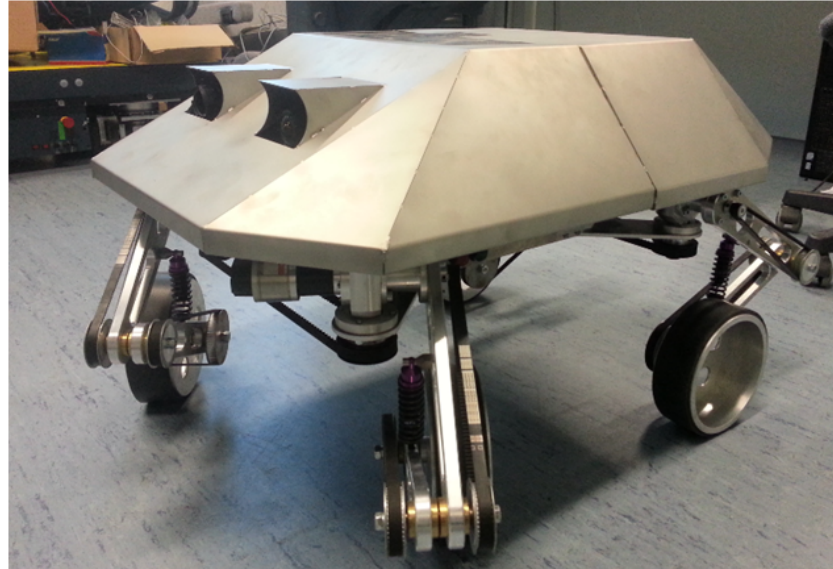
Figure 1. Automated guided vehicle (AGV).